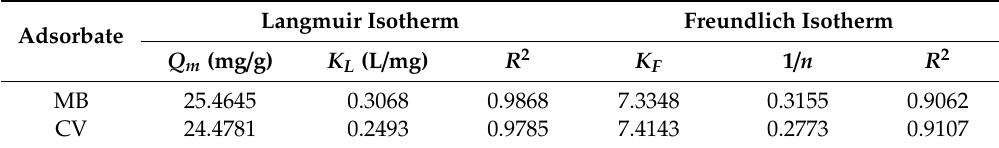
Table 2. Langmuir and Freundlich constants for adsorption of methylene blue (MB) and crystal violet (CV) onto rice husk. C e : the dye concentration in aqueous solution after reaction (mg / L); K L : Langmuir adsorption constant (L / mg); Q m : maximum adsorption amount of dye per unit mass of RH (mg / g); K F : distribution coe ffi cient (L / g); n : Freundlich constant.